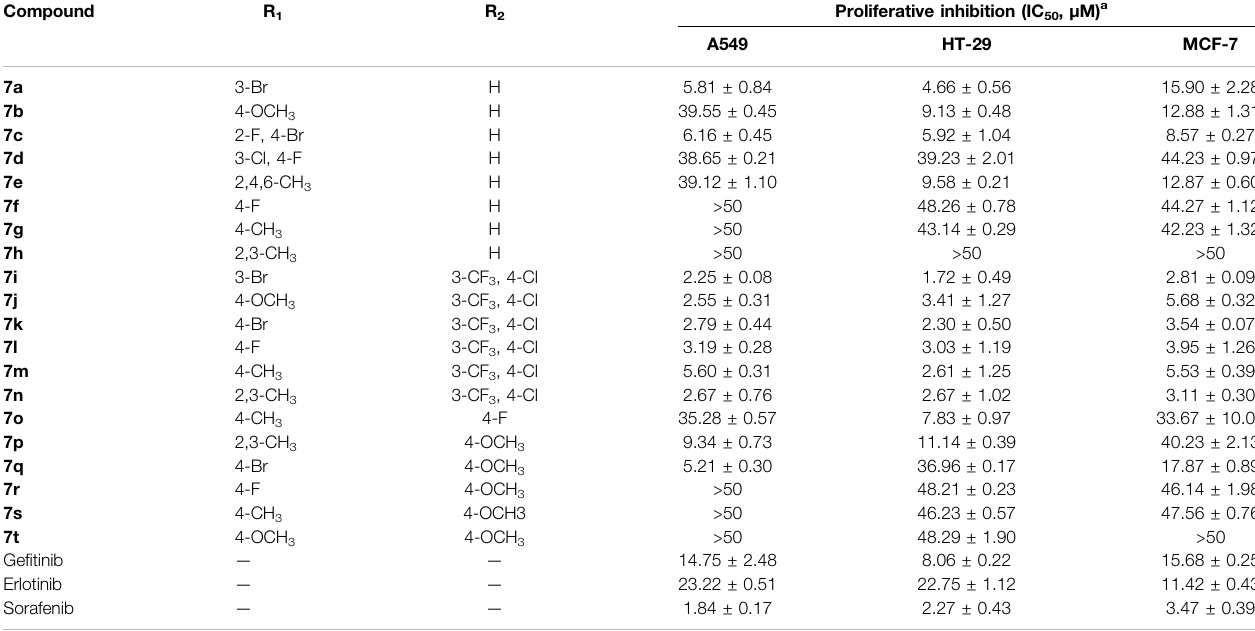
TABLE 1 | Cellular results for the Compound 7 series.